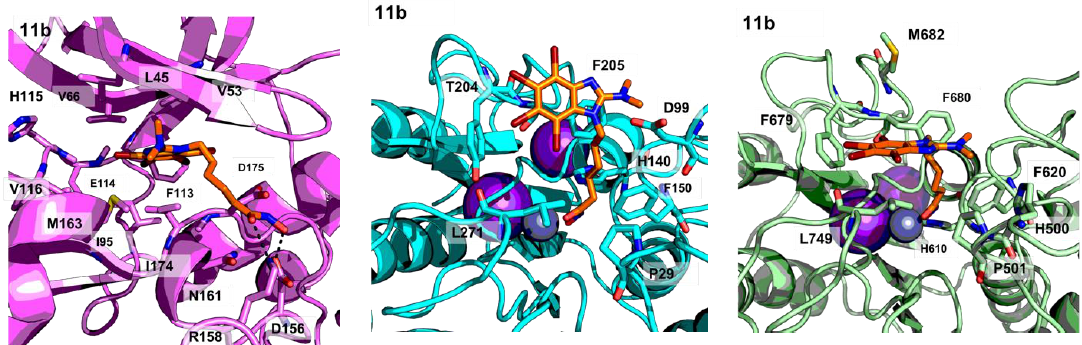
Figure 5. PyMOL stick and cartoon representation of the proposed binding modes of compound 11b to CK2 (magenta), HDAC1 (cyan) and HDAC6 (light green). For the sake of clarity, only heavy atoms are shown.